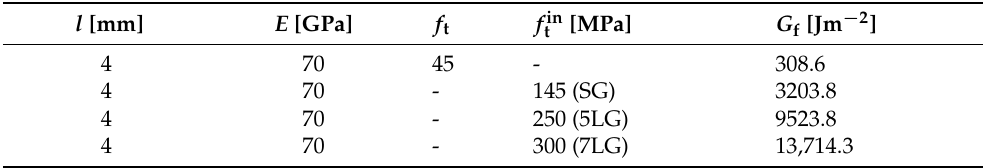
Table 3. Fracture energies G f of glass for quasi-static bending f t and initial tensile strength f in given length scale parameter l